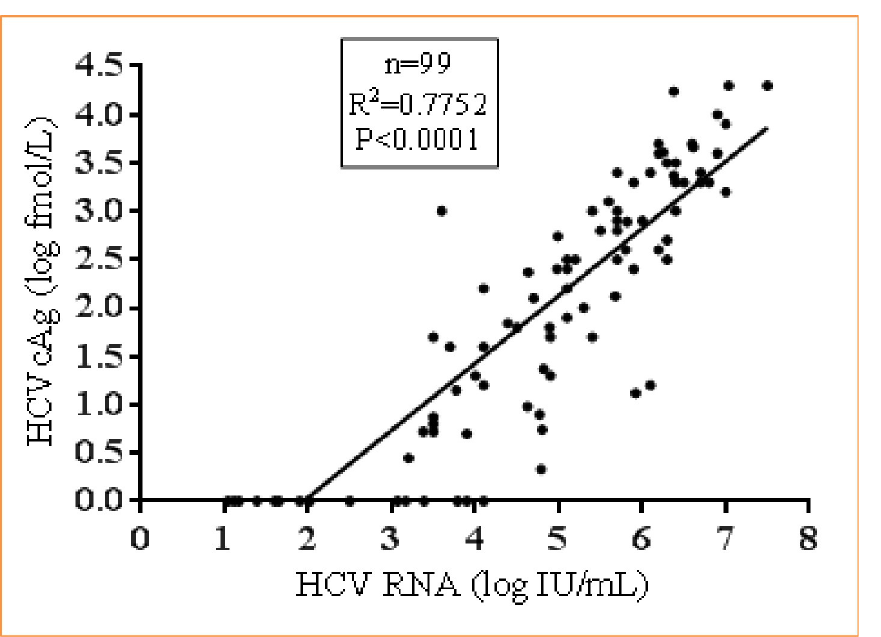
Fig 5. Correlation between HCV RNA and HCVcAg in HCV RNA and anti-HCV positive samples.